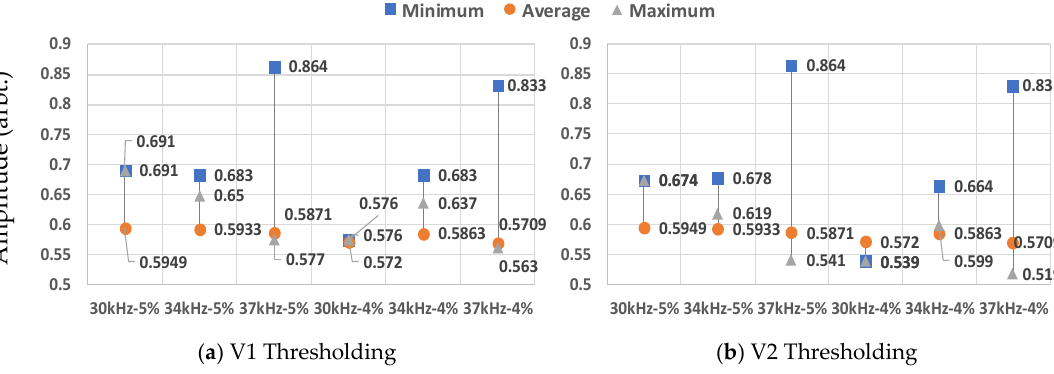
Figure 19. Limits achieved using method three on the second set of tests.